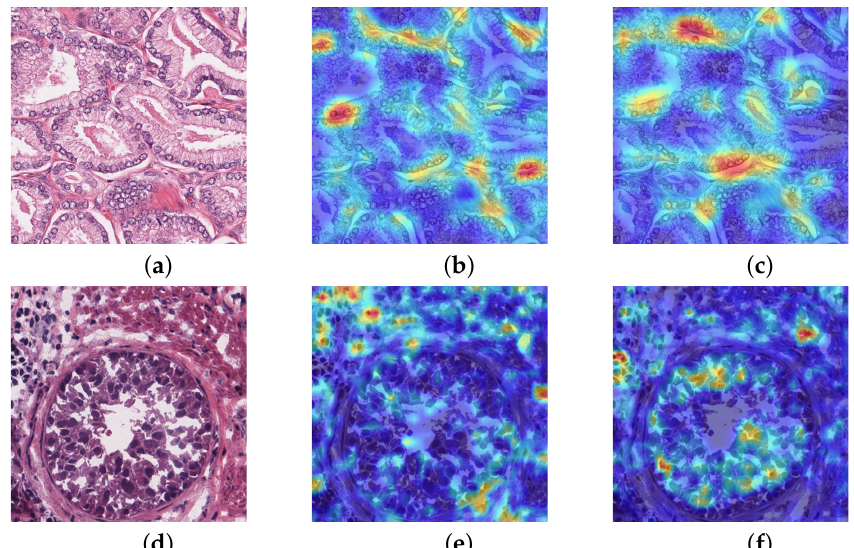
Figure 6. Class activation mapping ( a , d ) Histopathology image ( b , e ) U-net ( c , f )